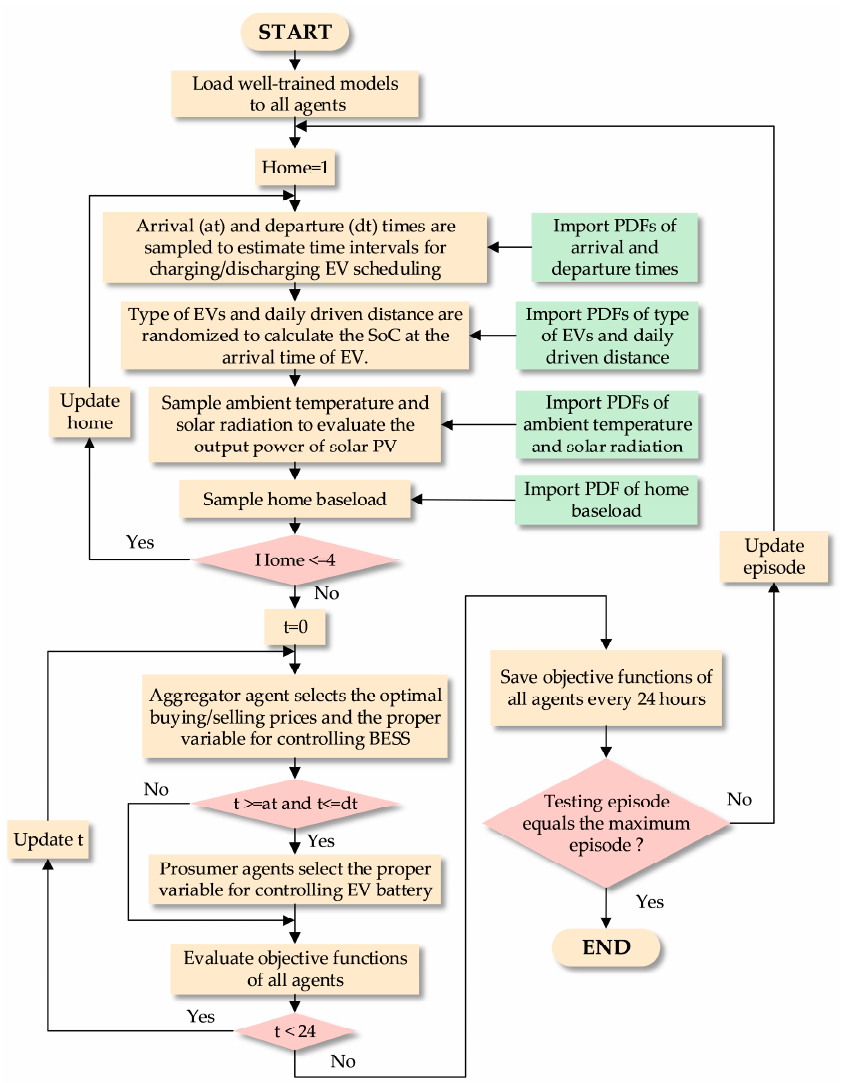
Figure 4. The testing procedure for multi ‐ agent optimization.